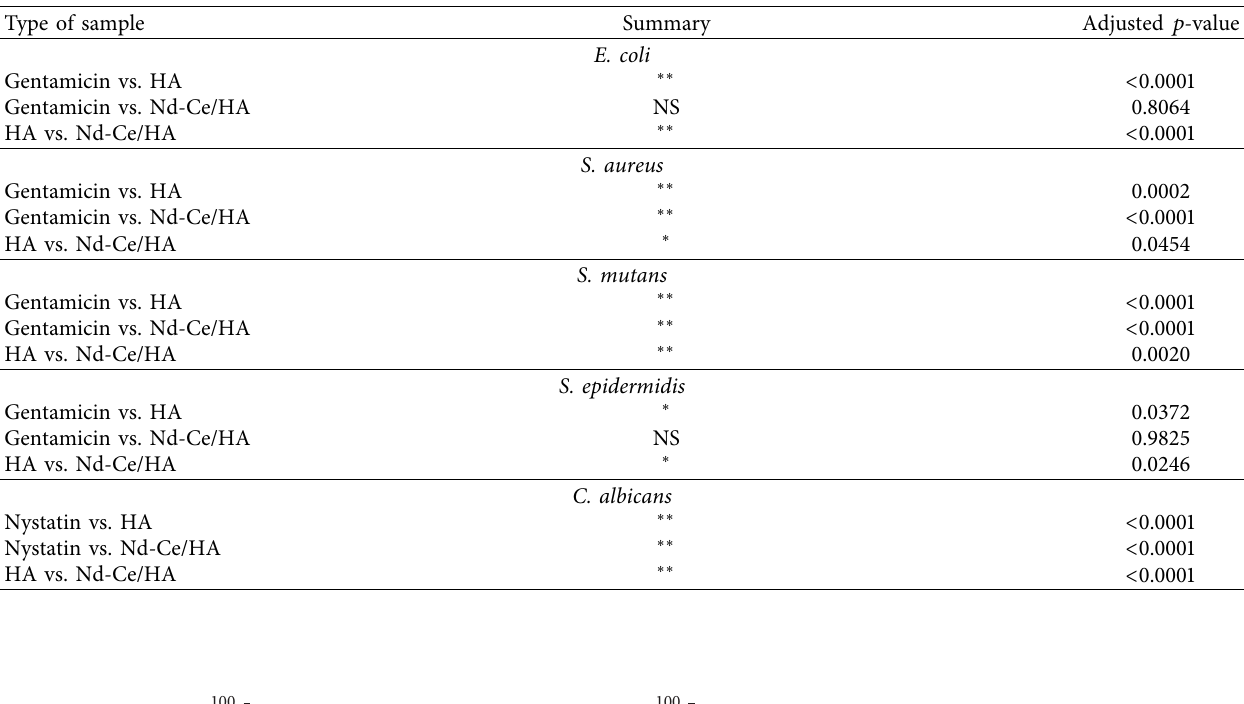
Table 4: Tukey’s multiple comparisons tests between gentamicin/nystatin, HA, and Nd-Ce/HA (NS means the probability ( p ) is non- signifcant, ∗ means p < 0 . 05, and ∗∗ means p < 0 . 01).